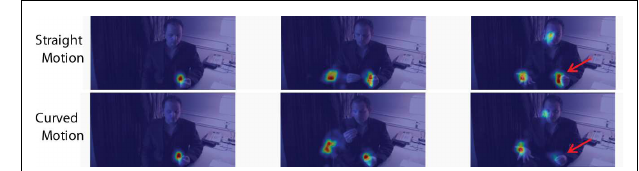
FIGURE 2 |Average eye positions of all subjects for three different video clip segments: before the right hand pretends to grab the coin, during the movement of the right hand, and after the right hand